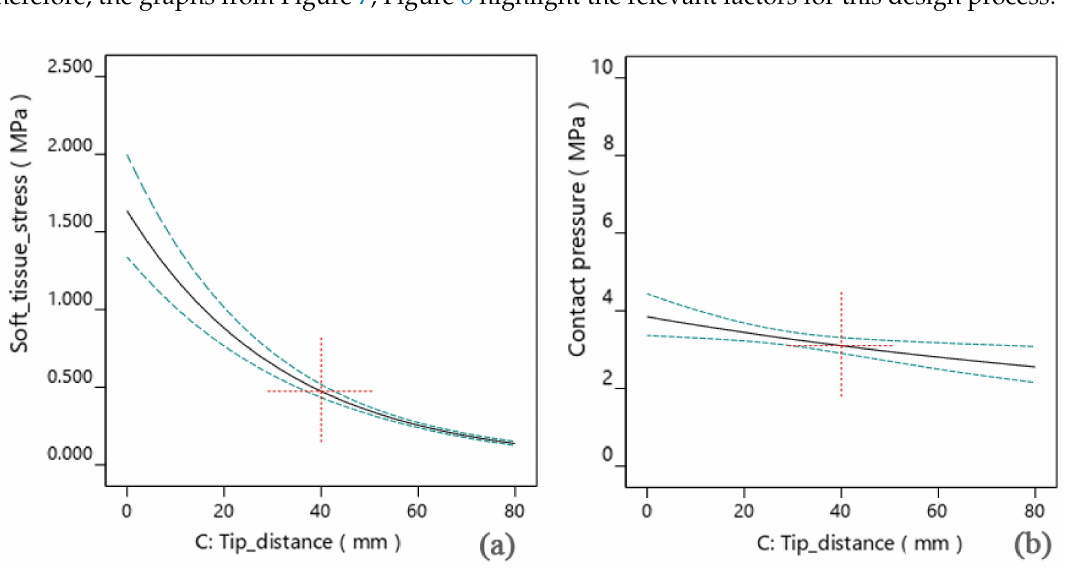
Figure 7. E ff ects of tip distance on soft tissue stress ( a ) and contact pressure ( b